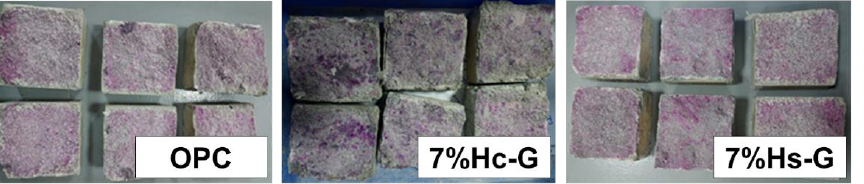
Figure 3. Carbonation front after 72 d exposure to 3% CO 2 .